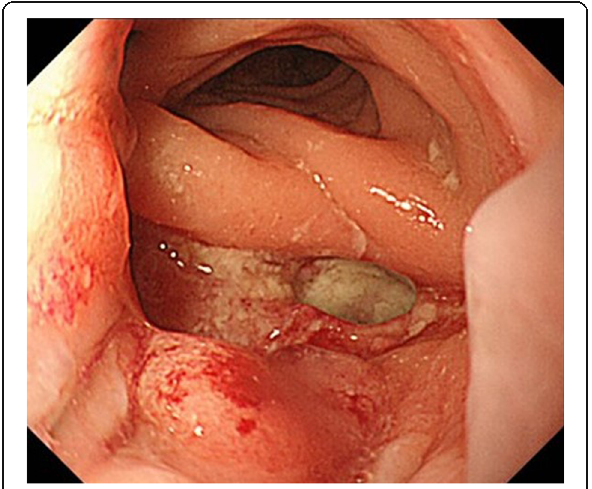
Fig. 2 Ulceration and fistula formation are observed at the site of the colonic anastomosis on